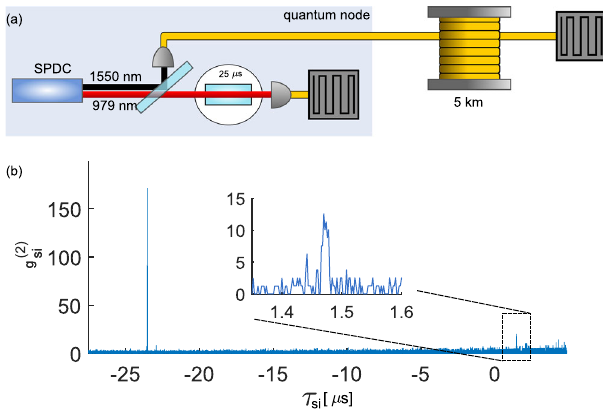
Fig.5|Remotedistributionthroughatelecom fi ber.a Aschematicofthestorage experiment with a 5-km long fi ber spool on the telecom mode, and a memory storage time of 25 μ s. b Second-order cross-correlation g ð 2 Þ si as a function of the relative detection time τ si . The peak at τ si =1.47 μ s (see inset) stems from coin- cidence detections with stored 979nm photons, whereas the larger peak at − 23.5 μ s is due to 979nm photons directly transmitted through the memory. τ si = The binning size is